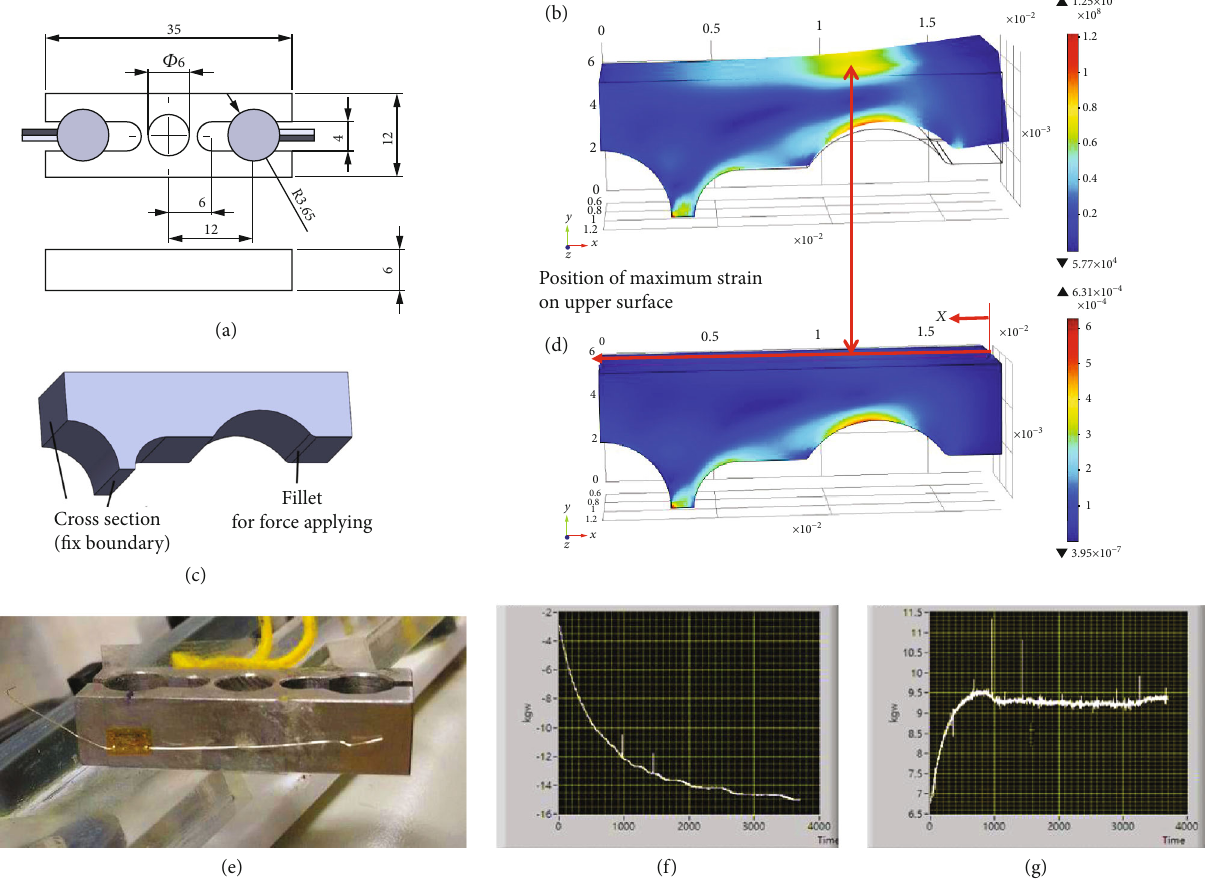
Figure 10: FEM simulations of the load cell. (a) Geometrical dimension (unit: mm). (b) Simpli fi ed quartered model. (c) Principal stress distributions. (d) Principal strain distributions. (e) Photograph of the load cell. (f, g) Drift e ff ects of the left and right sides of the load cell.